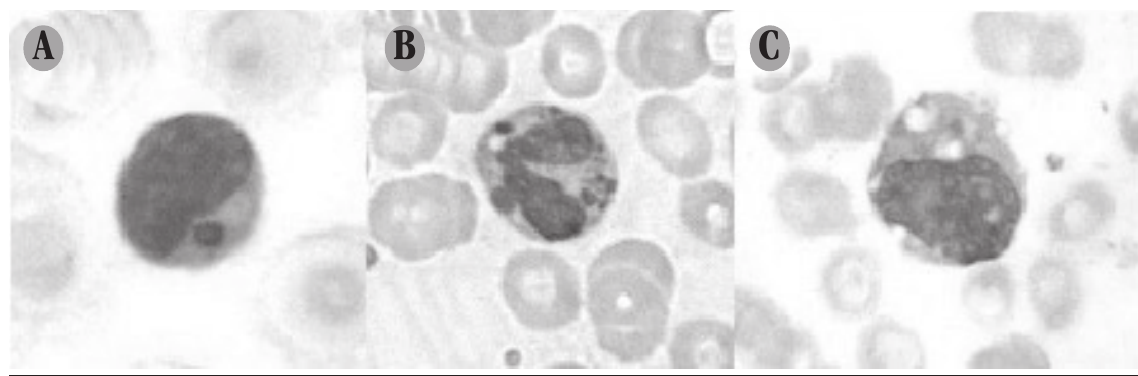
figurE 2 – Photomicrograph of peripheral blood smear of CHS patient Single giant azurophilic granules in lymphocyte (2A), multiple giant azurophilic granules in neutrophil (2B) and monocyte (2C) (Wright, 100×). CHS: Chediak-Higashi